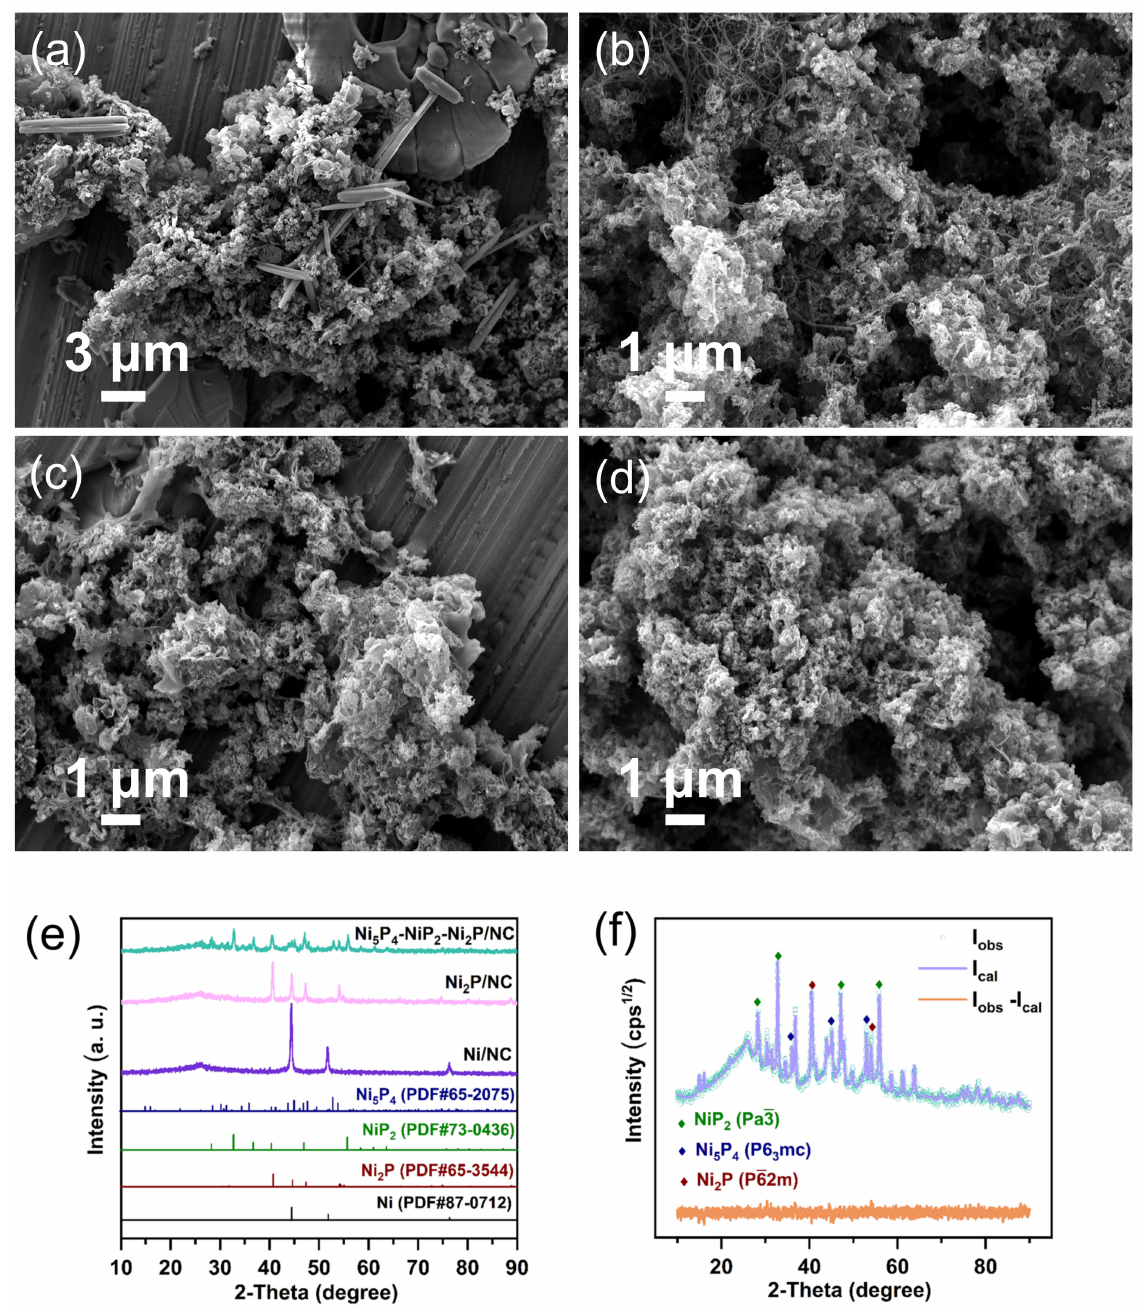
Figure 2. SEM images of ( a ) Ni(bpy)(NO 3 ) 2 /g-C 3 N 4 /Ni(dmgH) 2 , ( b ) Ni/NC, ( c ) Ni 2 P/NC, and ( d ) Ni 5 P 4 -NiP 2 -Ni 2 P/NC; ( e ) XRD patterns of Ni/NC, Ni 2 P/NC, and Ni 5 P 4 -NiP 2 -Ni 2 P/NC samples; ( f ) XRD experimental and fitting patterns for Ni 5 P 4 -NiP 2 -Ni 2 P/NC. G-of-F (R wp %) parameter is 1.12 (4.1). Figure 3a–c demonstrate TEM images of Ni 5 P 4 -NiP 2 -Ni 2 P/NC. Here, nickel phos- phide nanoparticles with sizes in the range of 10 to 100 nm are distributed in the carbon matrix composed of carbon nanotubes and carbon particulates. Furthermore, the SAED pat- tern in Figure 3d shows the polycrystalline diffraction rings and scattering dots, indicating the coexistence of Ni 5 P 4 , Ni 2 P, and NiP 2 . HRTEM analysis reveals that the lattice spacing of 0.32 nm is ascribed to the (111) plane of NiP 2 phase, cf. Figure 3e, and the lattice spacings of 0.55 and 0.22 nm belong to the (002) plane of Ni 5 P 4 and the (111) plane of Ni 2 P in Figure